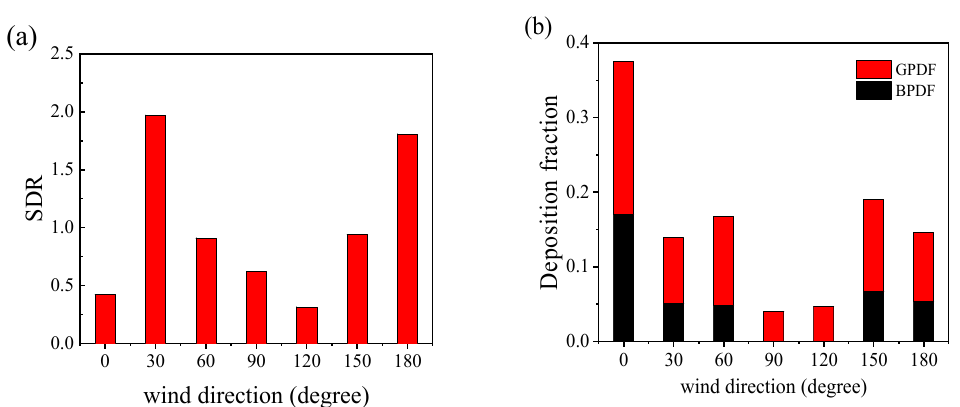
Figure 13. Spatial diffusion range of the droplets and the deposition fraction under different con- ditions: ( a ) the droplets’ spatial diffusion range at t = 4 s; ( b ) the droplets’ deposition rates on the ground and manikin body at the end of the simulation.